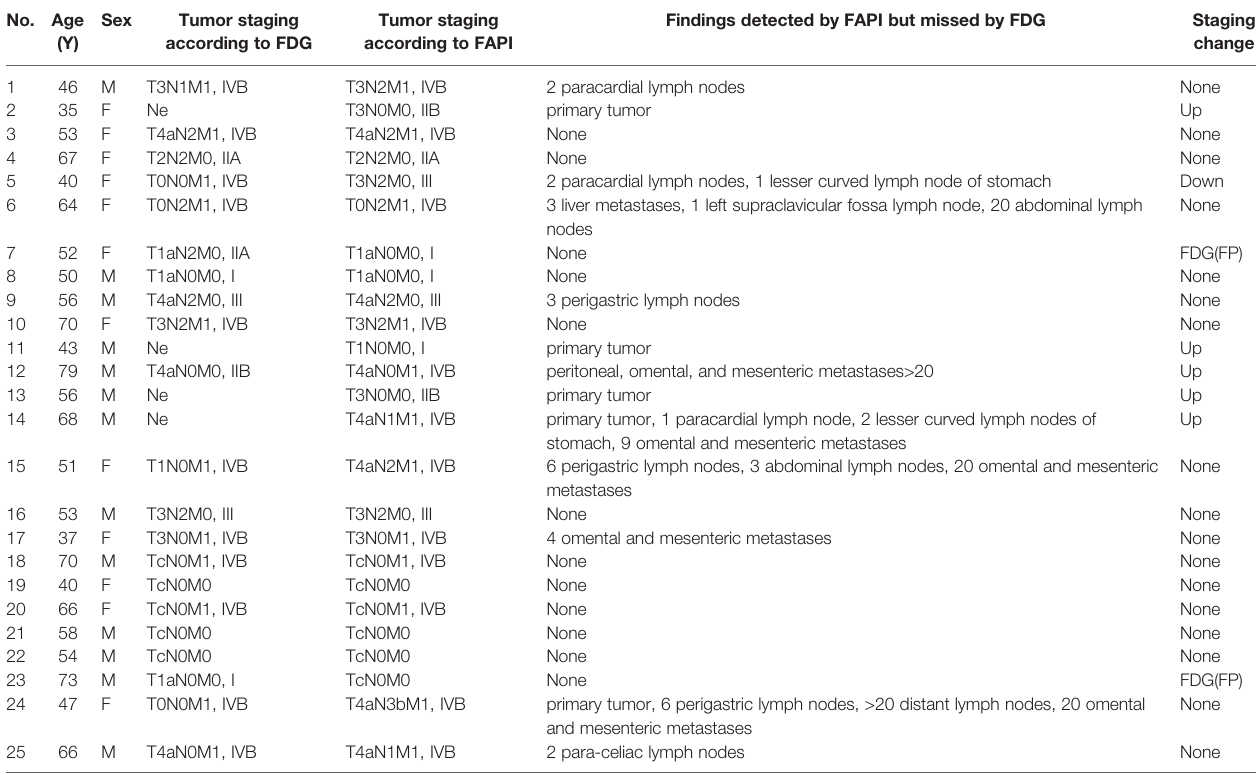
TABLE 3 | Changes in tumor staging and restaging by [ 68 Ga]Ga-FAPI-04 PET/CT.